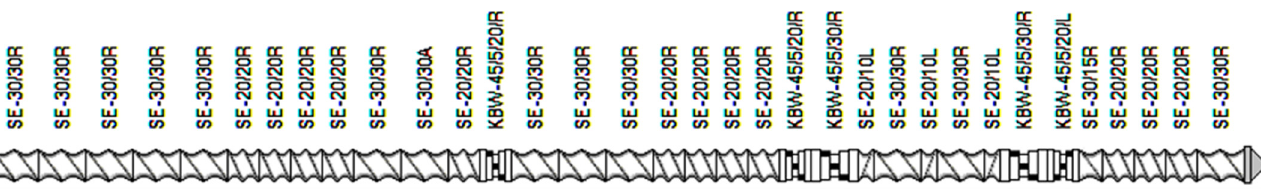
Figure A1. Screw configuration (from start (left) to end) used for high-moisture meat analogue (HMMA) extrusion (KETSE 20/40D extruder, Brabender GmbH and Co., Duisburg, Germany). SE = screw element, KBW = kneading block.